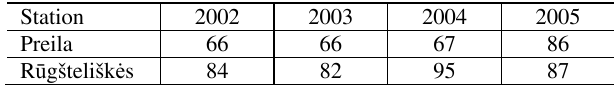
Table 1 . Number of analysed events at the background